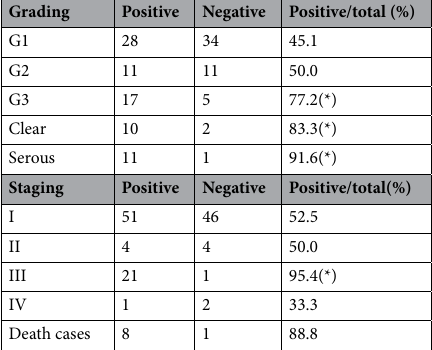
Table 1. Expression pattern of CT45A5 in endometrial cancer tissue. Expression of CT45A5 in endometrial cancer tissues was investigated by immunohistochemistry. Patient characteristics are shown in Supplementary Table S6 online. The entire slide was evaluated by the Allred scoring system in which two categories (stain intensity and stain pattern) were evaluated as described in Supplementary Table S2. The positive level of CT45A5 in undifferentiated cancer cells involved in G3/serous/clear was significantly higher than that in the G1 group. The level of CT45A5 in advanced cases was significantly higher than that in stage I (* p <